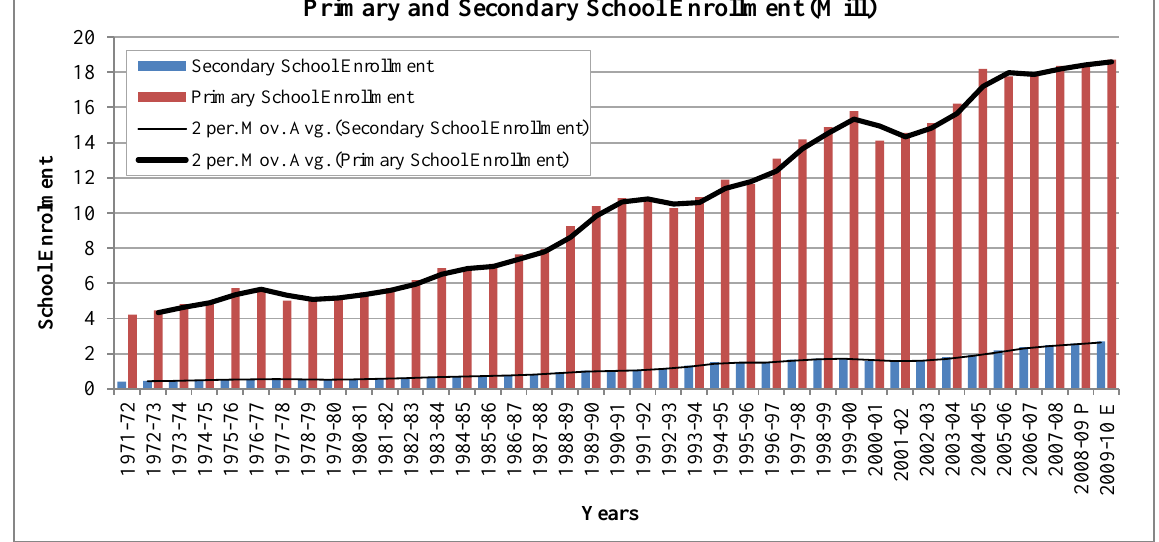
Figure 3. Primary and Secondary School Enrolment (Mill)